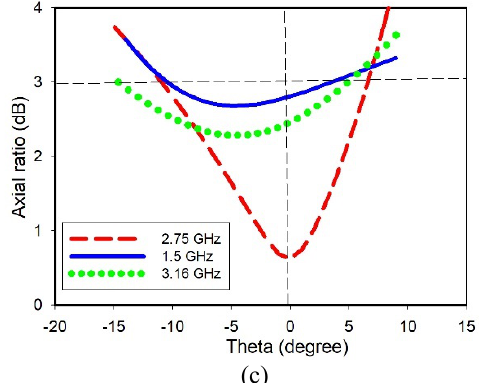
Figure 8: Variation in characteristics of the proposed antenna (a) reflection coefficient magnitudes, and (b) axial ratio values, versus frequency (c) axial ratio values, versus theta The variation in the AR values with the elevation angle ( q ) is plotted and shown for the three resonance frequencies in Fig. 8(c). The AR values can be observed to be below 3dB for a minimum variation of +/-5 o from the central axis for the three resonance frequencies. The radiation patterns for the proposed antenna at its resonance frequencies were measured in a Satimo Star-Lab near-field chamber. The values obtained were plotted and compared against the simulated ones for phi=0 o and phi=90 o orthogonal planes as seen in Fig. 9. The cross-polarization values are below -20 dB. In addition, RHCP is radiated in the upper hemisphere. The radiation were recorded at the three resonance frequencies as 80% /